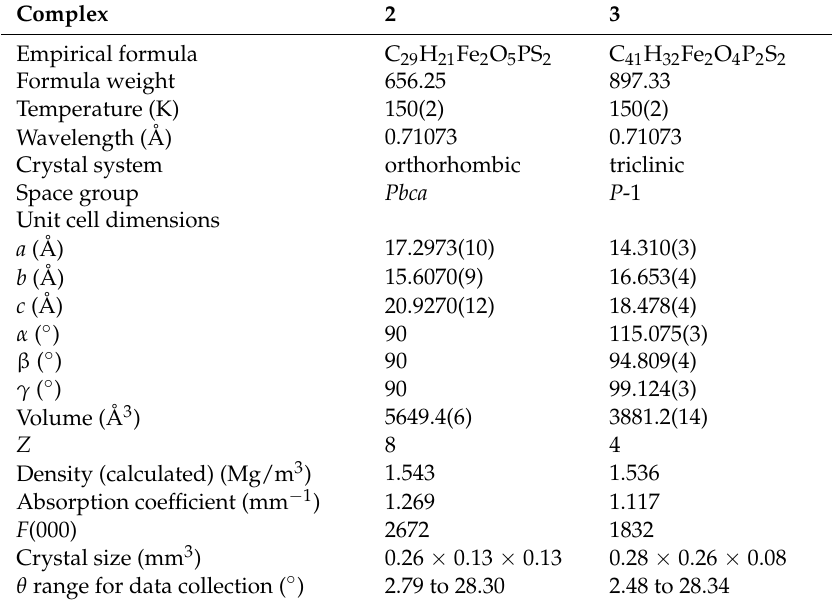
Table A1. Crystal data and structure refinement